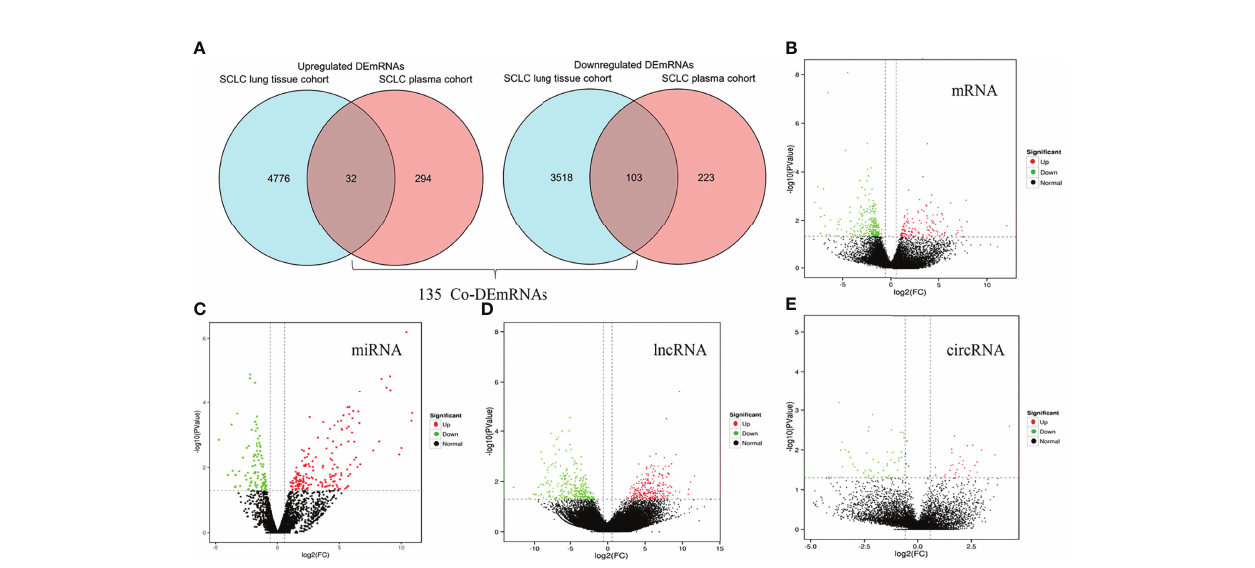
FIGURE 2 | Identi fi cation of differentially expressed mRNAs, miRNAs, lncRNAs and circRNAs in SCLC. (A) Common differentially expressed mRNAs (Co-DEmRNAs) in the in-house SCLC plasma cohort and the SCLC lung tissue cohort (GSE40275). (B) Up- and downregulated mRNAs in our cohort. (C) Up- and downregulated miRNAs in our cohort. (D) Up- and downregulated lncRNAs in our cohort. (E) Up- and downregulated circRNAs in our cohort. Red indicates upregulated and green indicates downregulated; circRNA, circular RNAs; lncRNA, long noncoding RNA; miRNA, microRNA; mRNA, messenger RNA; SCLC, small cell lung